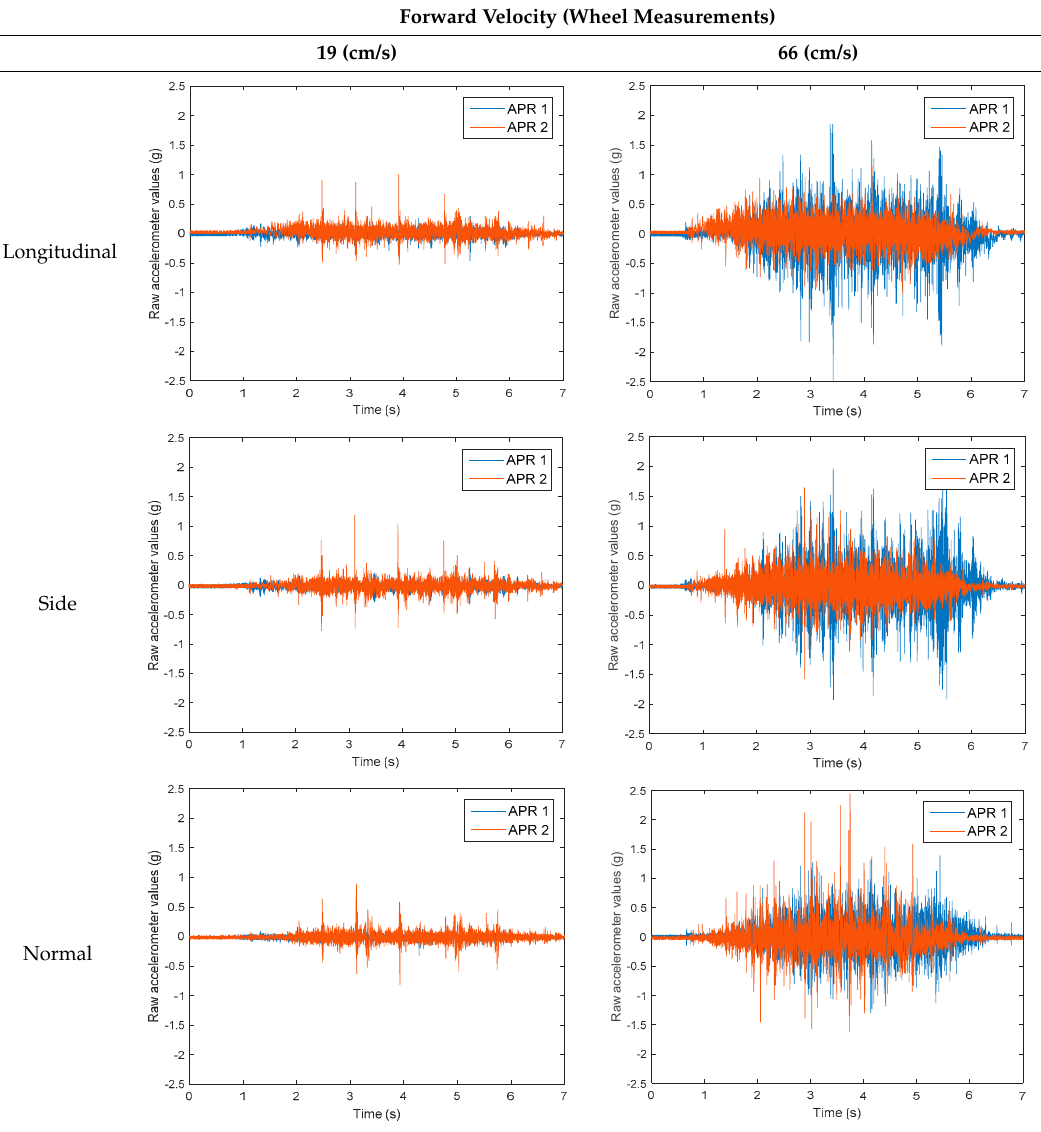
Table 3. Vibration representation measured in the wheel of the APR-1 and APR-2 prototypes.